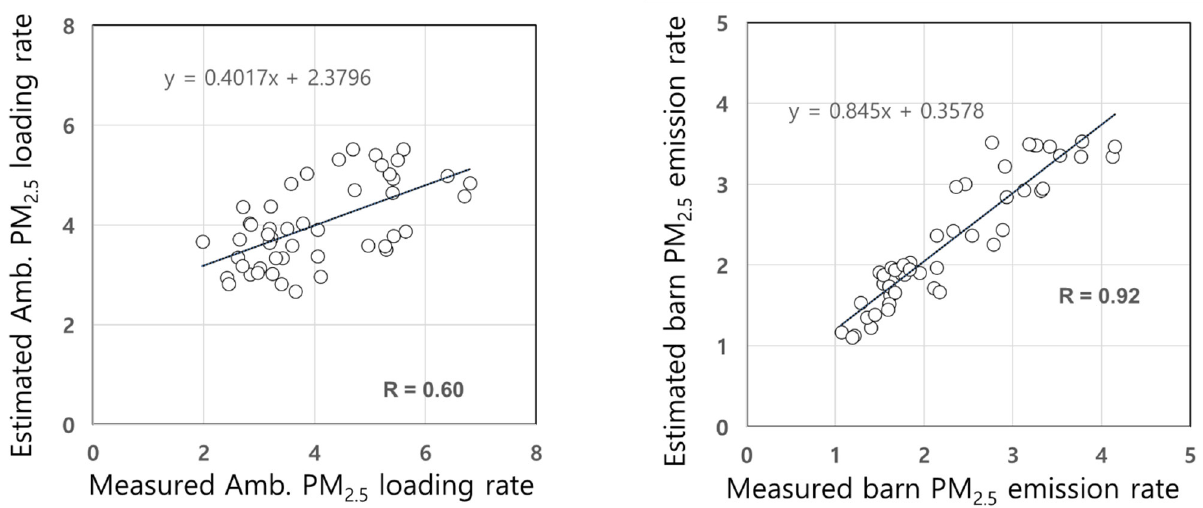
Figure 9. Correlations between direct PM 2.5 measurements and estimated PM 2.5 (from the multivariate linear regressions): PM 2.5 loading ( left , p < 0.001) and emission rates ( right , p < 0.001).